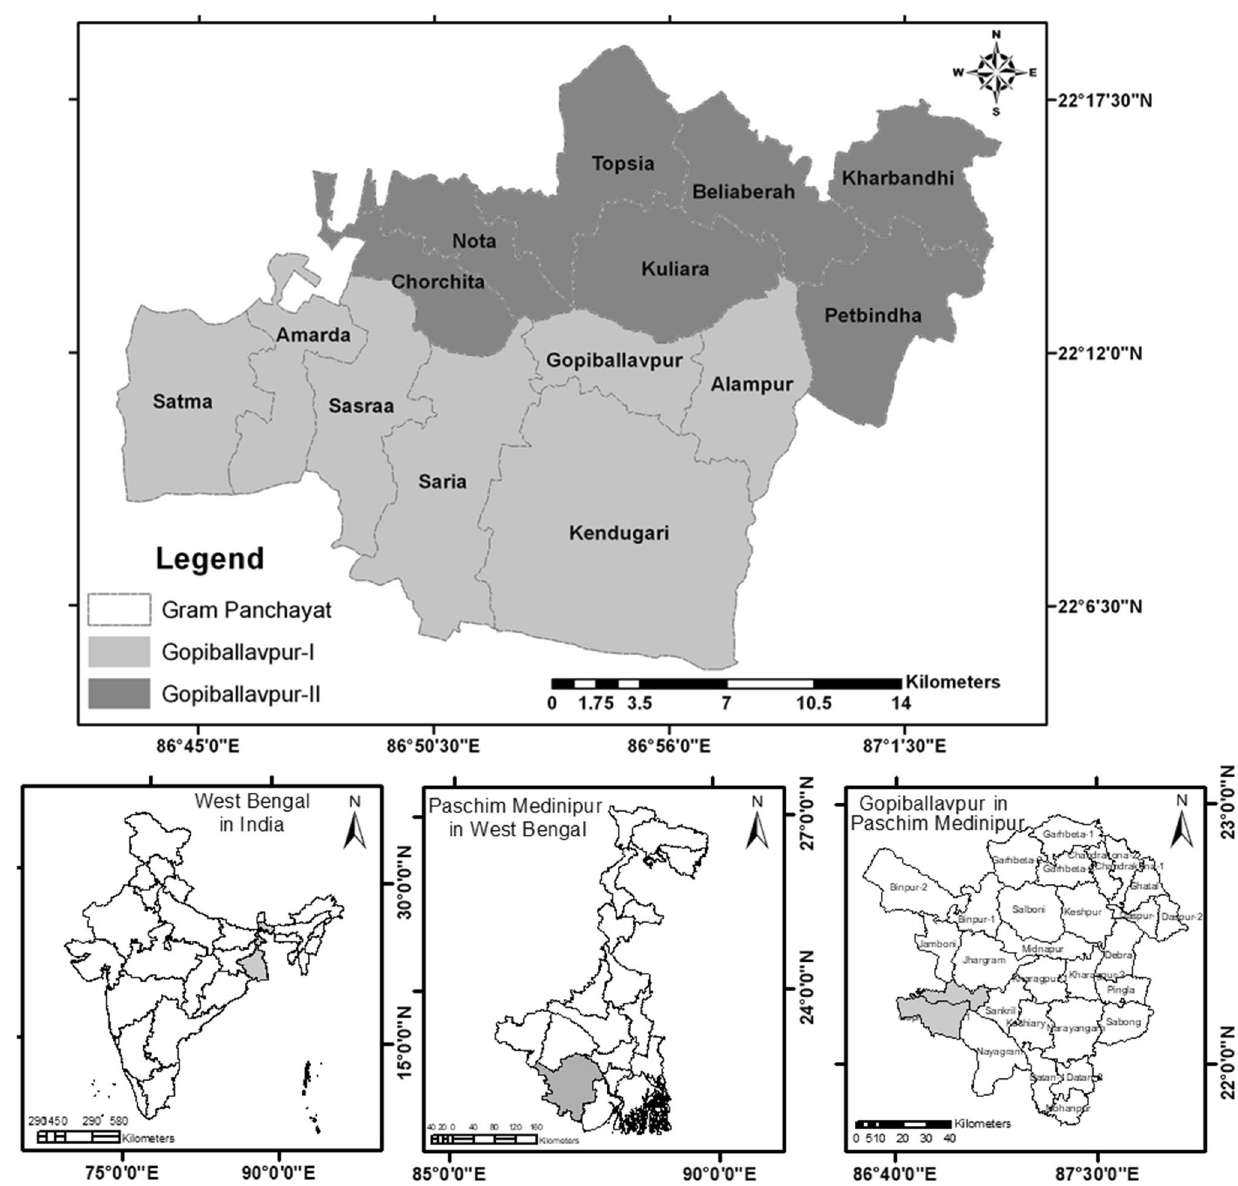
Fig. 1 Location map of the Gopiballlavpur block, Paschim Medinipur district, West Bengal